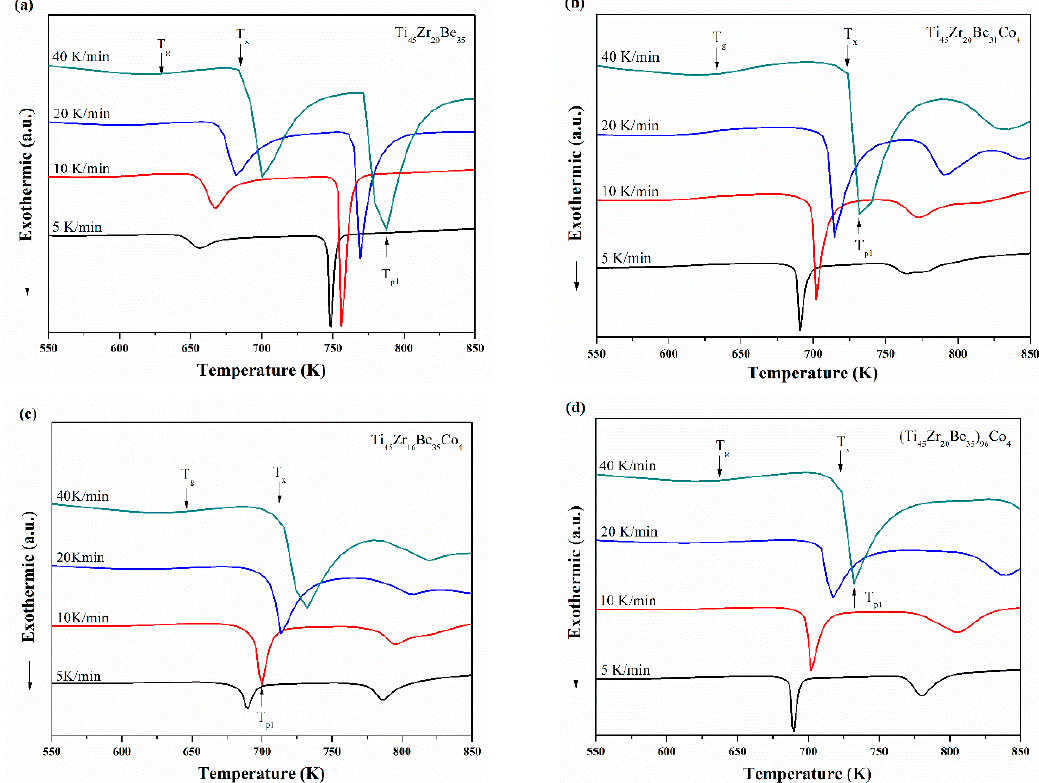
Figure 8. Continuous DSC curves for ( a ) Ti 45 Zr 20 Be 35 , ( b ) Ti 45 Zr 20 Be 31 Co 4 , ( c ) Ti 45 Zr 16 Be 35 Co 4 , and ( d ) (Ti 45 Zr 20 Be 35 ) 96 Co 4 BMGs.